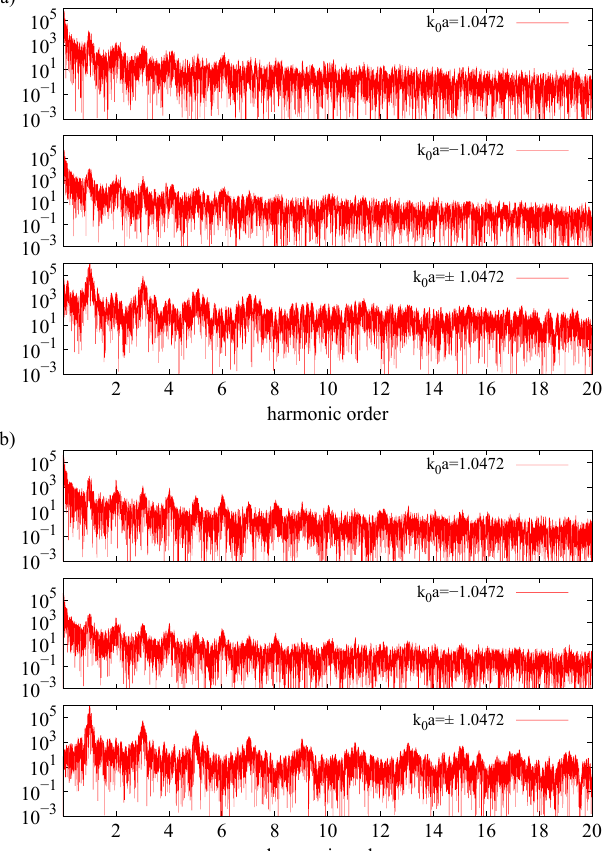
Figure 5. The suppression of even-order harmonics. Panel ( a ) [( b )] corresponds to U ( a ) [ U ( b ) ] . In both panels, the contributions of given values of k is shown together with that of − k and their combined effect, for parameters F 0 = 4.0GV/m (2.13 10 12 W/cm 2 peak intensity), λ L = 3µm and τ = 300fs.